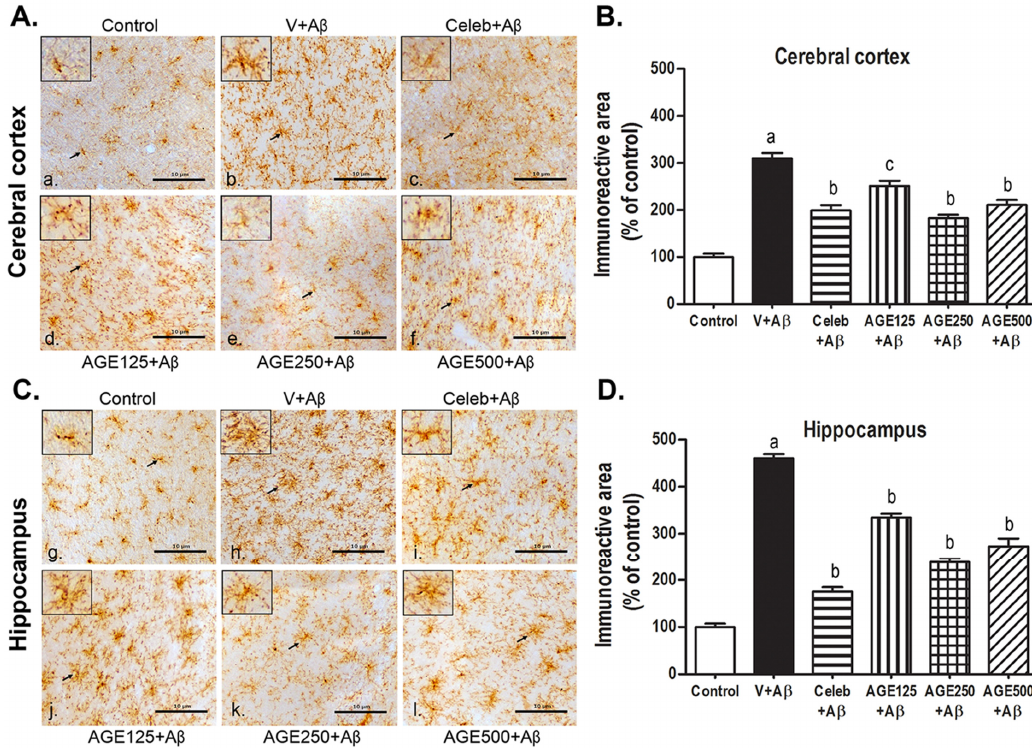
Figure 3. Effect of AGE on CD11b immunoreactivity in the cerebral cortex and hippocampus of the rat brain: ( A , C ) the photomicrographs of brain sections showing the distribution of microglia activating cells by immunohistochemistry staining in the cerebral cortex and hippocampus, respectively; Control ( a , g ); V + A β ( b , h ); Celeb + A β ( c , i ); AGE125 + A β ( d , j ); AGE250 + A β ( e , k ) and AGE500 + A β ( f , l ); arrows point to examples of microglia cells in the rectangular frame; ( B , D ) The bar graphs represent the CD11b immunoreactive area in the cerebral cortex and hippocampal regions of the rat brain. Data are presented as mean ± S.E.M., a = significant differences from control group at p < 0.001 and b, c = significant differences from vehicle + A β group at p < 0.001 and p < 0.01, respectively.